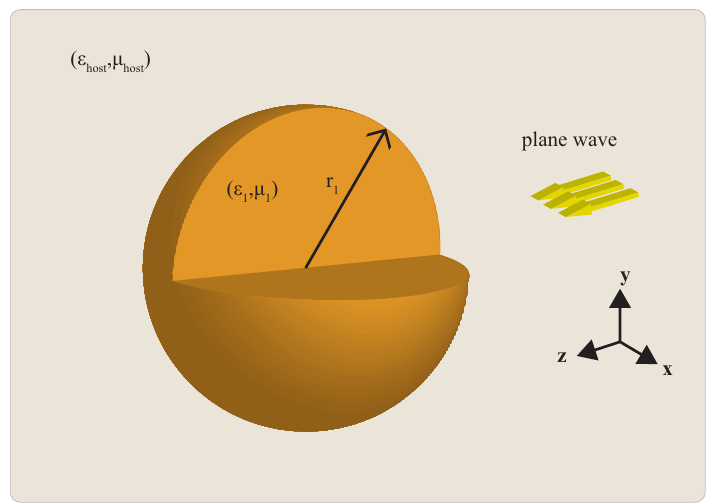
Figure 1. Conceptual visualization of the general problem under consideration: plane wave scattering by a sphere of radius r 1 and material ε 1 , µ 1 in a host medium with general material parameters ε host , µ host . In this review, the host medium is vacuum with ε host = 1, µ host = 1 and the sphere is magnetically inert, i.e., µ 1 = 1. The plane wave is z propagated, E x